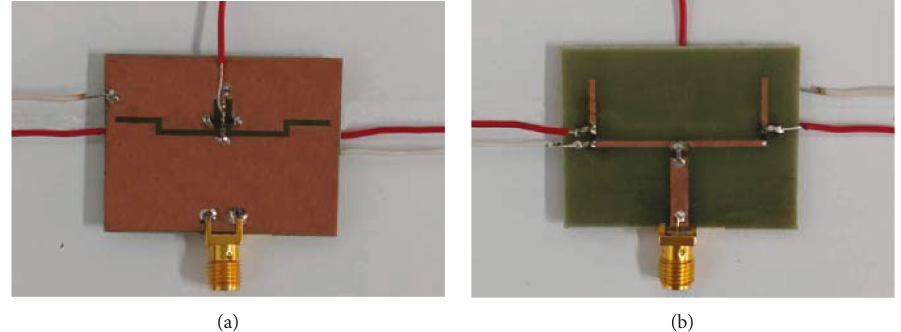
Figure 9: Photograph of the antenna. (a) Top view. (b) Bottom view.